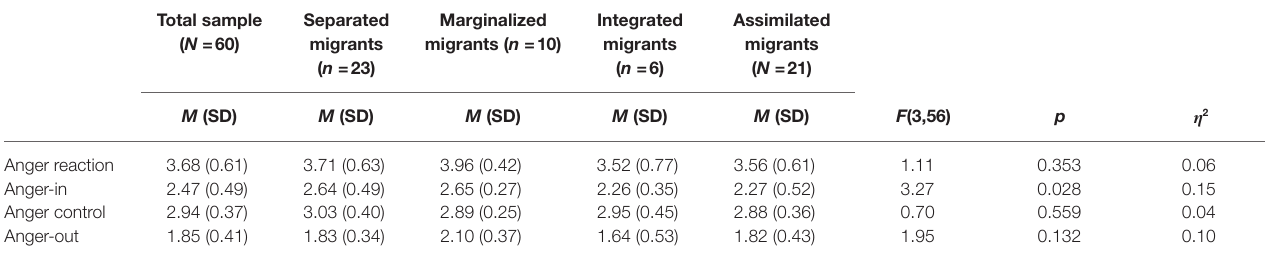
TABLE 5 | Means and standard deviations of anger-reaction, anger-control, anger-out, and anger-in separately for the acculturation orientations assimilation, integration, separation, and marginalization among participating Iranian migrants ( N = 60), Iranians, and Germans. Total sample ( N = 60)